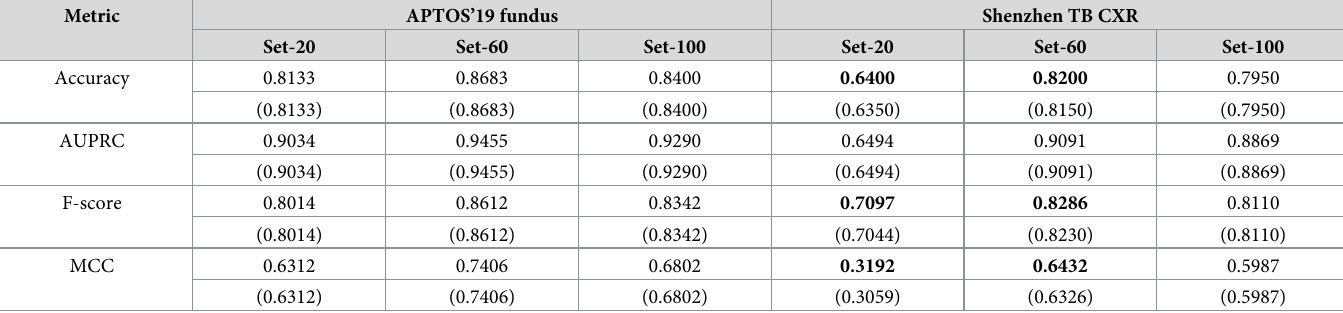
Data in parenthesis denote the performance achieved with uncalibrated probabilities and data outside the parenthesis denotes the performance achieved with calibrated probabilities. The best performances are denoted by bold numerical